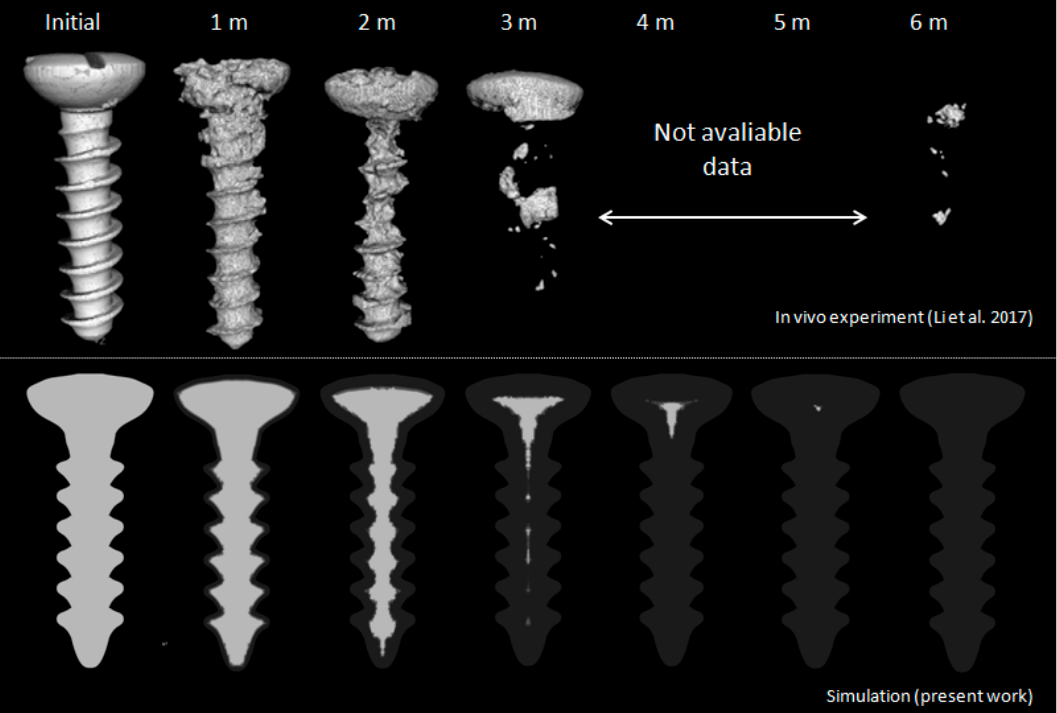
Figure 4. Validation of the simulation of magnesium screw degradation obtained by the mathematical modeling presented by Sanz-Herrera et al. [118] ( bottom ), compared with the experimental setup by Li et al. [119] ( top ). Reprinted with permission from [118].